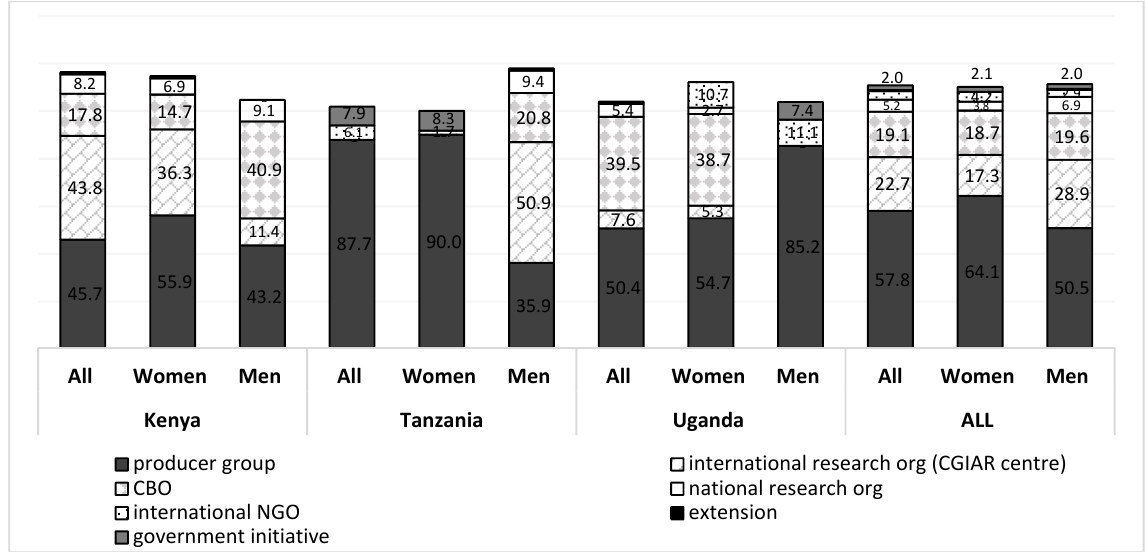
Figure 4. Formal and informal institutions used as seed sources.